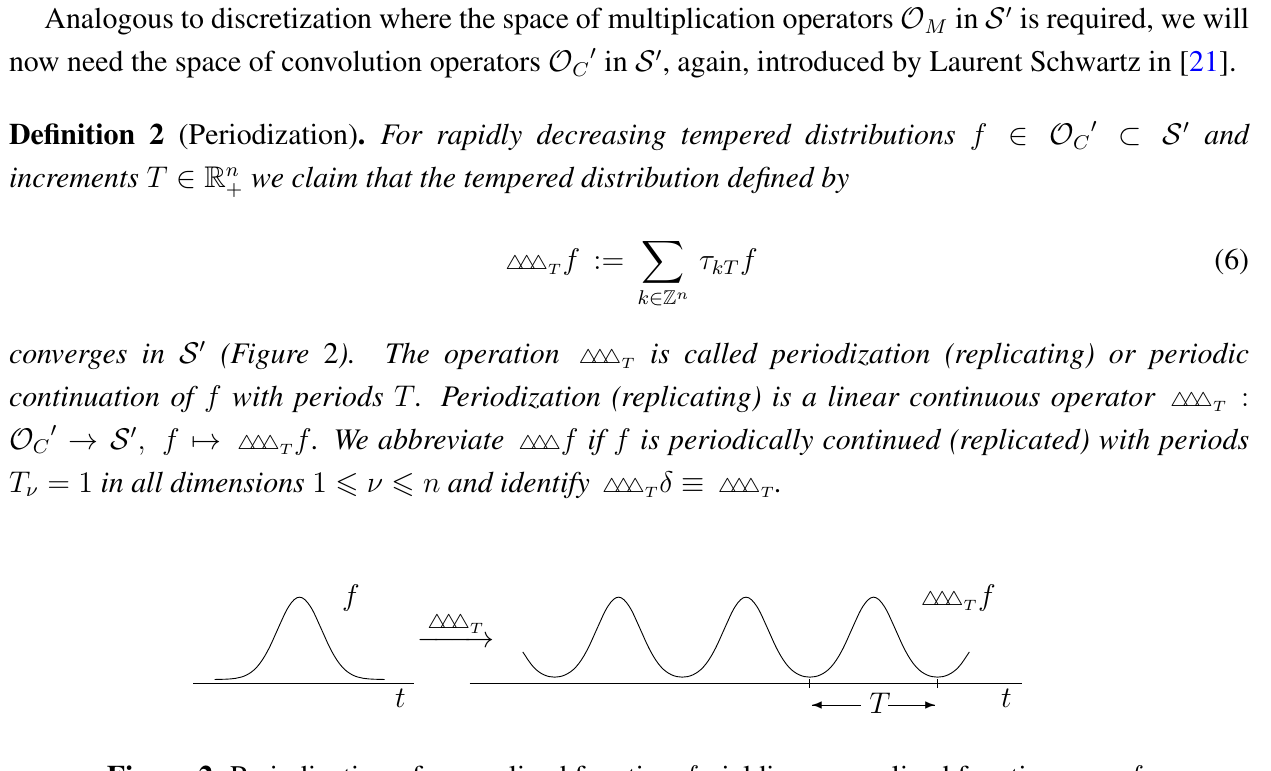
Figure 2. Periodization of generalized function f yielding generalized function △△△